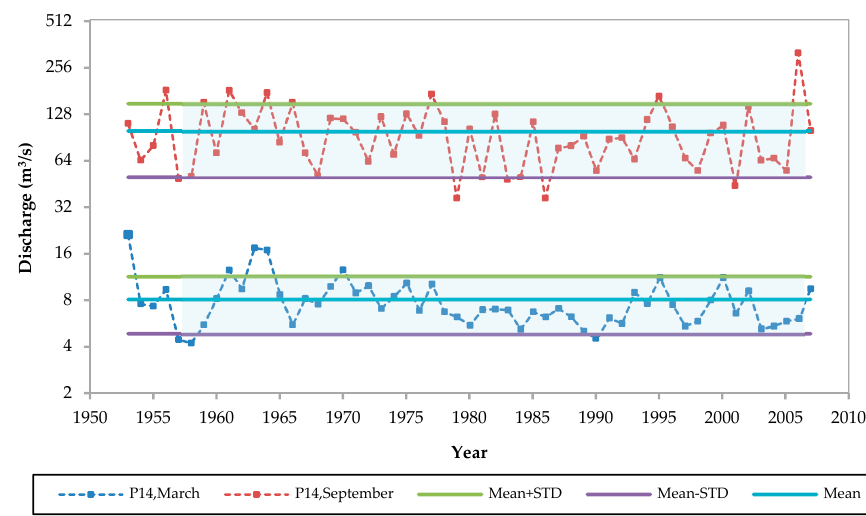
Figure 2. The variability of mean streamflow in September and March for various years at gauge station P14.